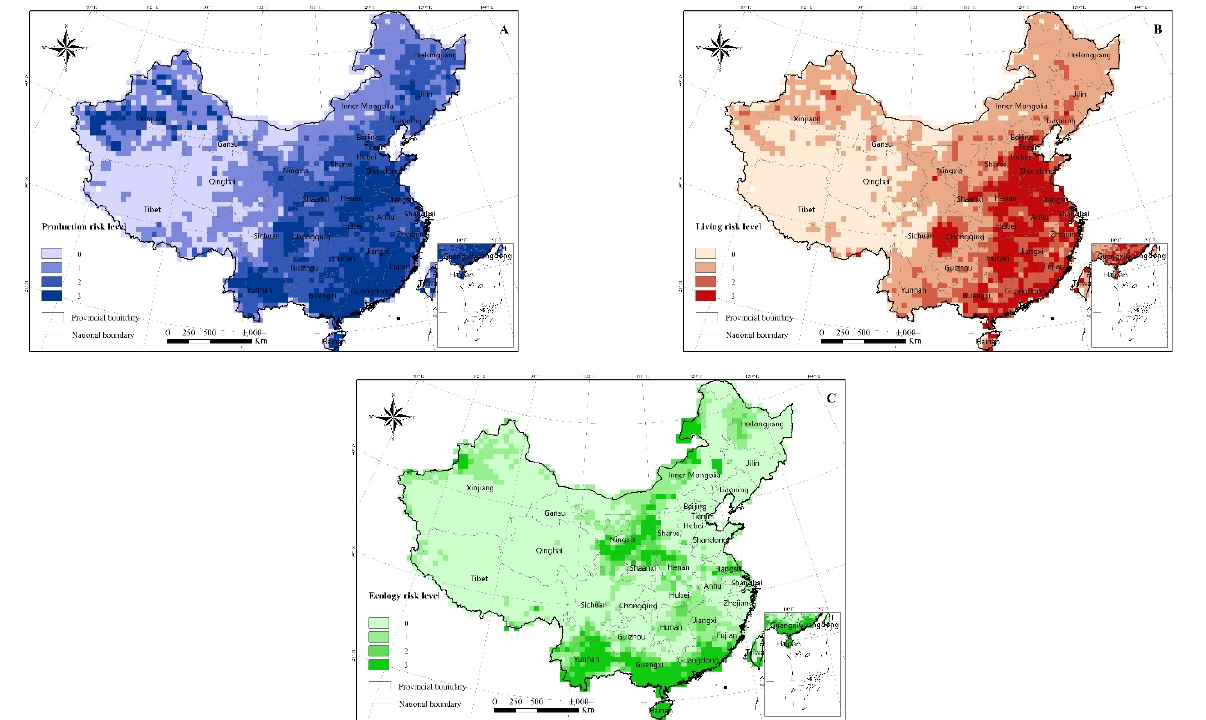
Figure 2. Distribution pattern of production ( A ), living ( B ), and ecological ( C ) risk level at grid scale under climate change scenario.